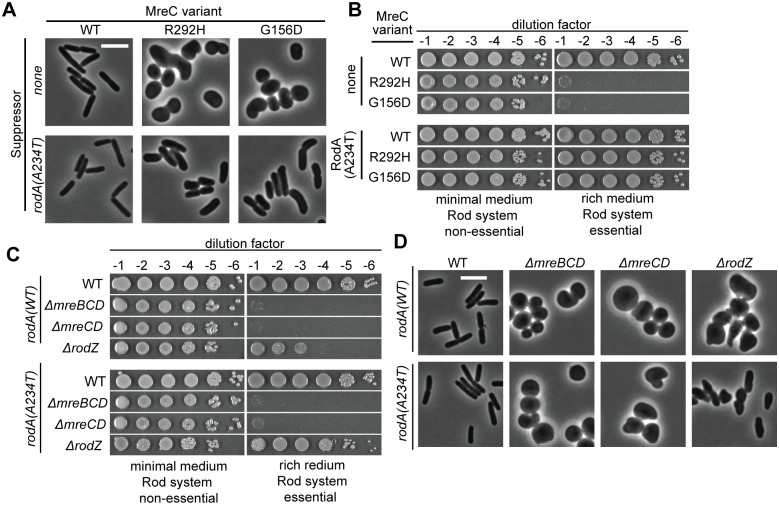
RodA(A234T) suppresses mreC missense mutants and ΔrodZ but not ΔmreCD.A. Strains containing the indicated missense mutations at the native genomic locus [PR158, PR159, PR160, PR161, PR162, PR163] were grown and imaged as in Fig 2A. B. Overnight cultures of the above strains were serially diluted and spotted on either M9 CAA glu agar (Rod non-essential) or LB agar (Rod essential). Plates were incubated at 30°C for either 40 h (M9) or 16 h (LB) before imaging. C. Overnight cultures of the indicated strains [PR150, PR152, PR153, PR154, PR151, PR155, PR156, PR157] were serially diluted and spotted as in Fig 3B. D. The indicated strains were grown, fixed, and imaged as described in Fig 2A.